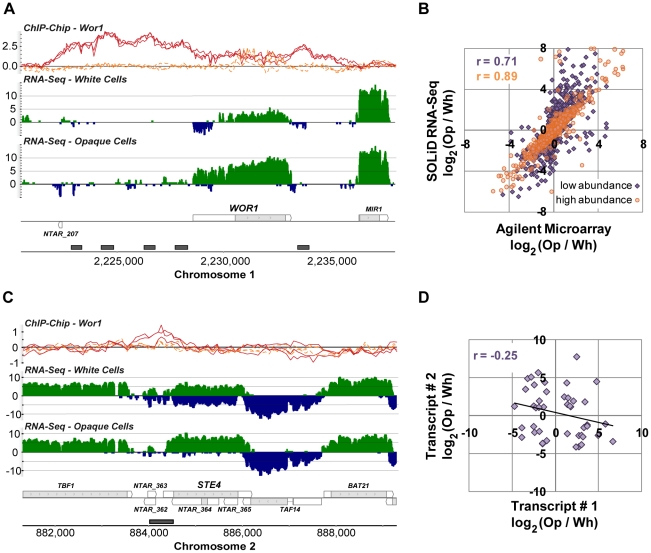
Transcripts differentially expressed between white and opaque cell types.(A) Expression and Wor1 enrichment at the WOR1 locus as visualized in the MochiView Genome Browser [68]. In this and all other genomic plots presented here, Wor1 ChIP-Chip data are plotted in the top row (red-curves are from biological replicates of the Wor1 IP in opaque cells and orange curves are from IPs in wor1Δ Δ strains; normalized log2 IP DNA/Input DNA enrichment values are plotted), followed by RNA-Seq data for white and opaque cells (colored green on the plus and blue on the minus strand; values plotted are log2 sequence coverage), followed by transcript definitions in our new annotation (gray regions are coding and white are un-translated), and finally regions determined to be Wor1-bound by the peak finding algorithm (gray boxes). For interested readers, a MochiView database export of all the data presented in this work is provided at http://johnsonlab.ucsf.edu/mochi_files/Tuch_et_al_2010_PLoS_Genetics.cvw. (B) Comparison of RNA-Seq and microarray measurements of differential transcript expression (for previously annotated transcripts only). Transcripts are colored by their mean abundance across samples as measured by RNA-Seq: purple indicates mean RPKM ≤30 and orange indicates mean RPKM >30. (C) The expression of STE4 is anti-correlated with the expression of its antisense transcript. (D) The expression of sense-antisense transcript pairs is only modestly anti-correlated (ρ = −0.25; P-value = 0.05).